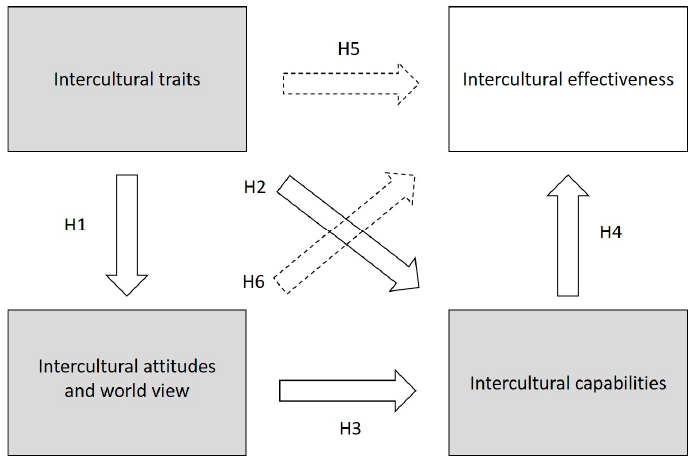
Figure 1. Hypotheses summary: test of an integrative framework. Note: The grey squares represent intercultural competence. The operationalizations of intercultural competence and effectiveness are presented in italic. H1, H2, H3, and H4 represent the empirical test of the integrative framework as proposed by Leung et al., 2014. H5 and H6 represent additional hypotheses in dashed arrows. All hypothesized relationships are expected to have positive effects.